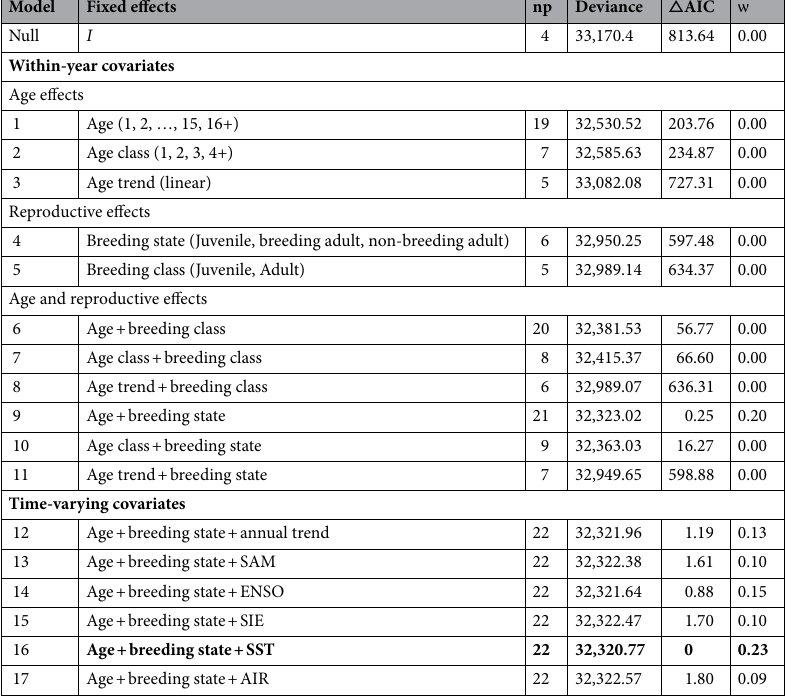
Table 3. Model selection of the variation in the moult haulout duration of female southern elephant seals over 32-years (1986–2018) at Marion Island. Year and individual identity were included as random effects in all models. The most parsimonious model is in bold. Model terms are as in Table 1. The environmental covariate AIR is air temperature at Marion